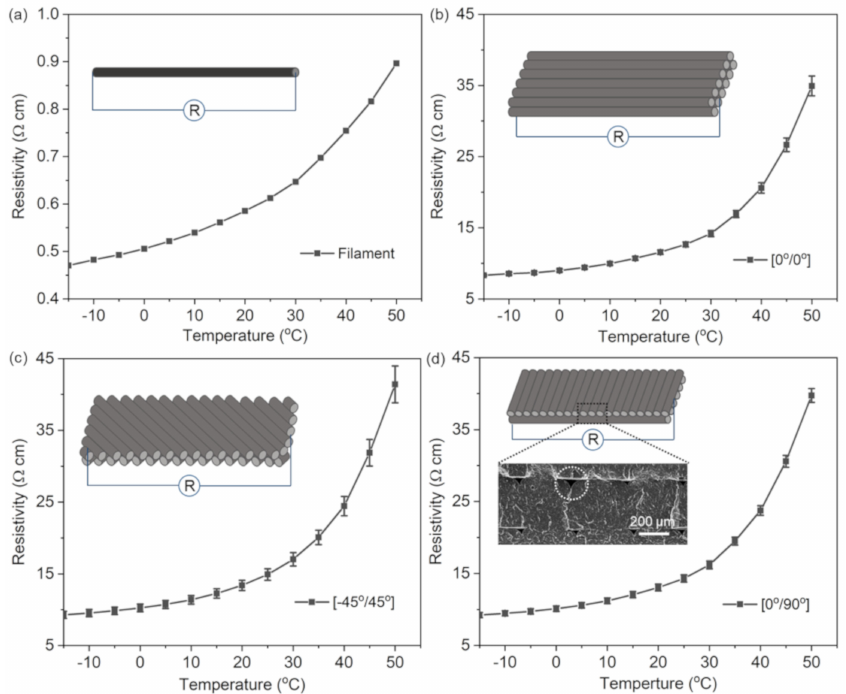
Figure 2. Resistivity variation of ( a ) a single PLA/CB filament; and 3D printed PLA/CB struc- tures with orientation angles of ( b ) [0 ◦ /0 ◦ ]; ( c ) [ − 45 ◦ /45 ◦ ]; and ( d ) [0 ◦ /90 ◦ ] plies, as a function of